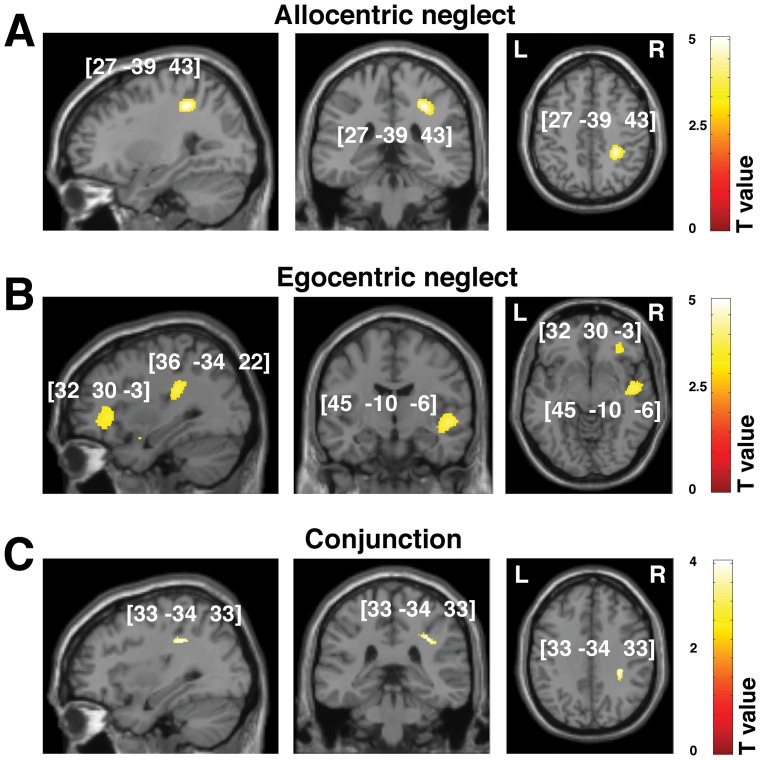
Voxel-wise statistical analysis of white matter damage: allocentric vs. egocentric neglect at the chronic phase following stroke.VBM results showing voxels corresponding to white matter damage in (A) left allocentric, (B) left egocentric neglect and (C) both forms of neglect (conjunction analysis). Please note that in A, B and C the lesioned areas are coloured according to their significance level in the VBM analysis, where a brighter colour indicates a higher t-value. The numbers in brackets indicate the peak MNI coordinates.